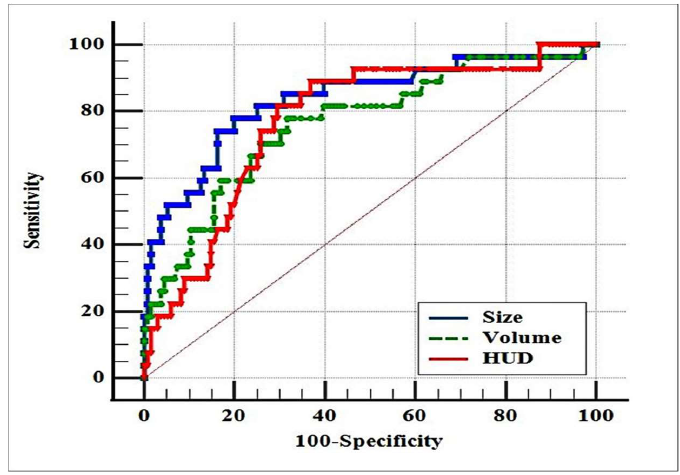
Figure 1. Receiver operating characteristic curves for stone size, volume, and density versus stone-free rate after MPCNL.